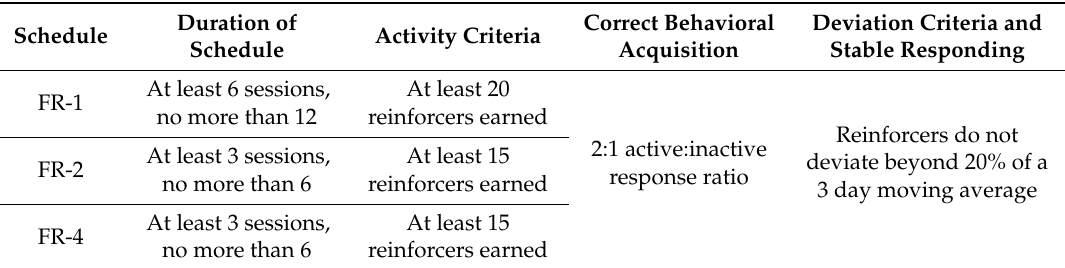
Table 1. Parameters for fixed ratio (FR)